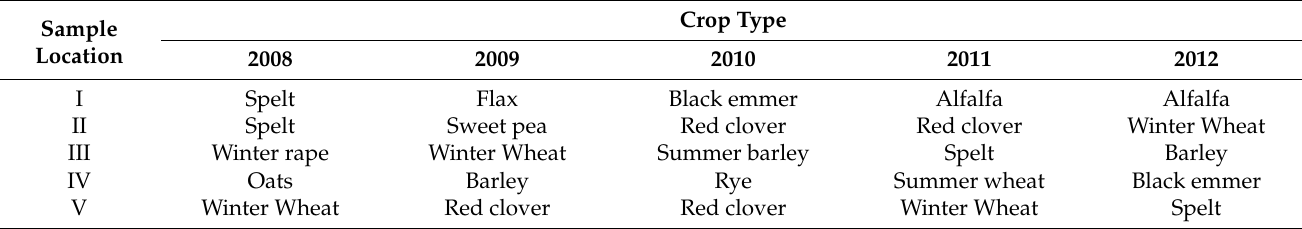
Table 1. Crop rotation from 2008 to 2012 of the investigated fields.